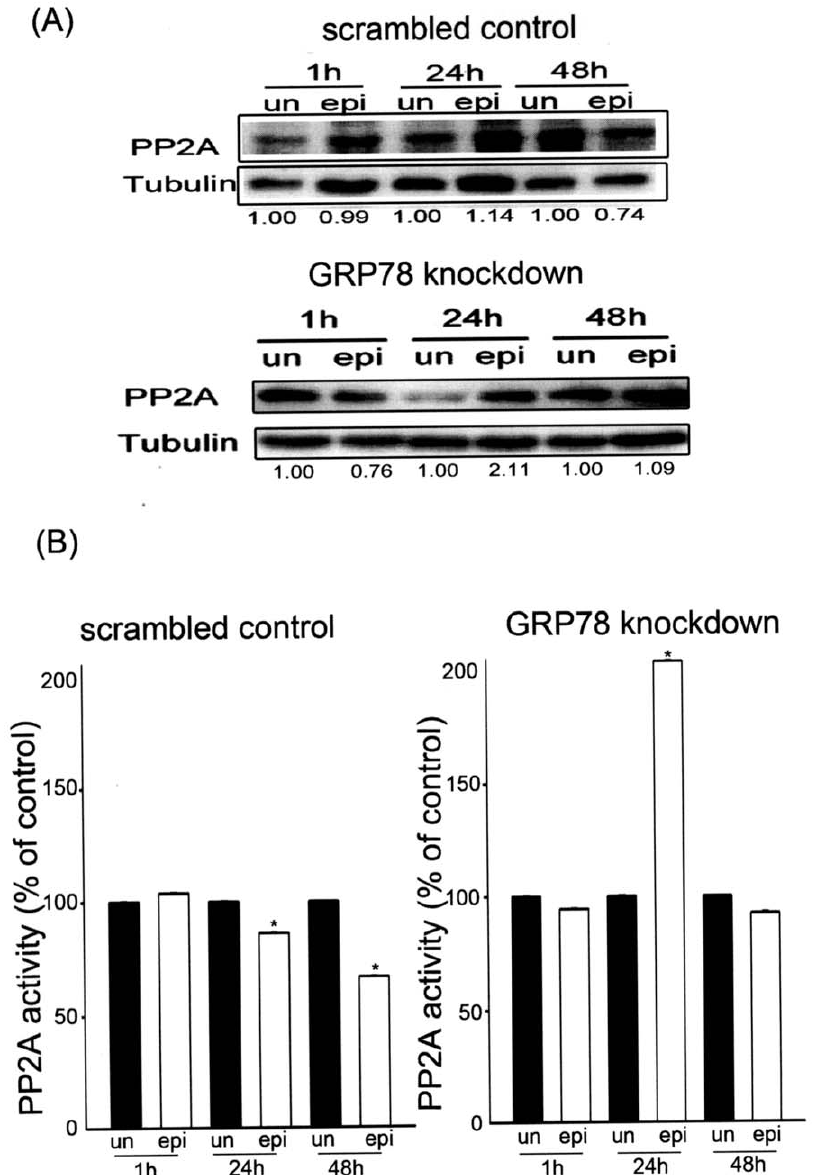
Figure 6. Expression and activity of protein phosphatase 2A (PP2A) after epirubicin (epi) treatment. Scrambled control and GRP78 knockdown DLD-1 cells were treated with epirubicin (500 ng/ml) for the indicated times. (A) The expression of PP2A was evaluated by western blotting, and (B) the activity of PP2A was determined as outlined in the Materials and Methods . These experiments were performed at least 3 times, and a representative experiment is